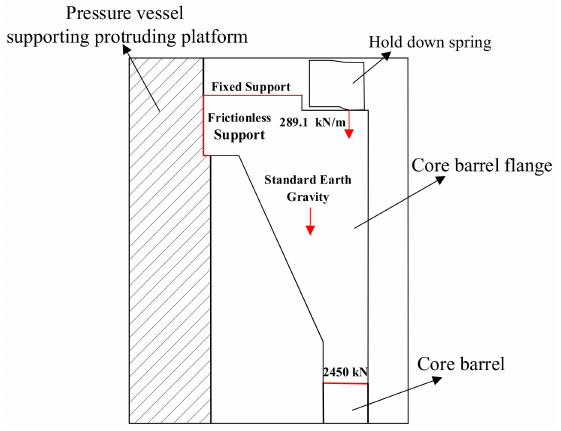
Figure 2. Schematic diagram of the core barrel flange.